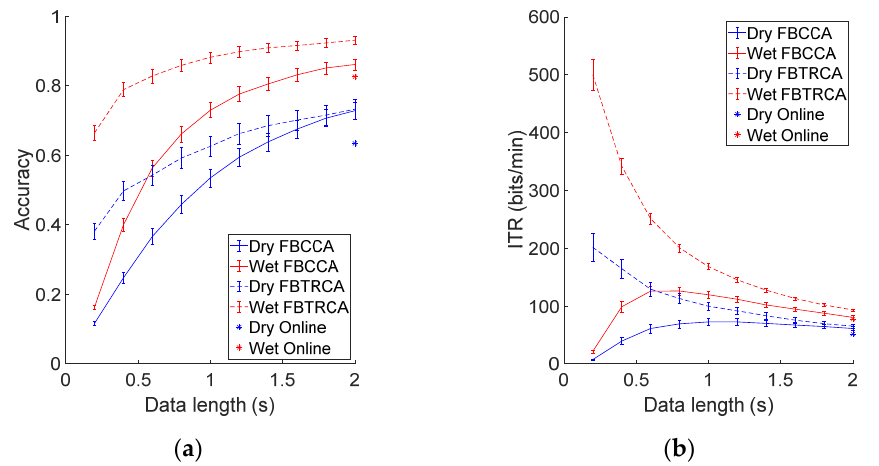
Figure 7. Averaged ( a ) classification accuracy and ( b ) ITR across all subjects of the FBCCA method and FBTRCA method with different data length (from 0.2 s to 2 s with a 0.2 s interval) for the dry and wet electrode. The error bars represent standard errors. The asterisk represents the perfor- mance of the online